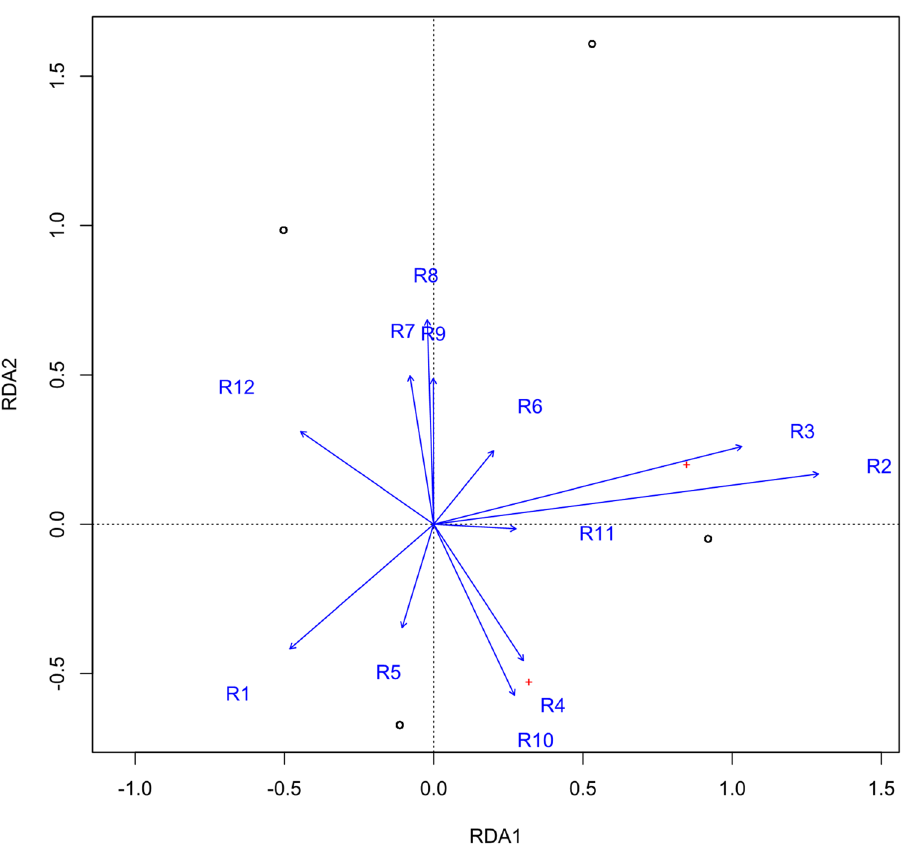
Figure 2. RDA analysis plot. The length of the arrow shows the strength of the correlation between the variable and the result variable. The longer the arrow length, the stronger the correlation. The vertical distance reflects the correlation between them. The smaller the distance, the stronger the